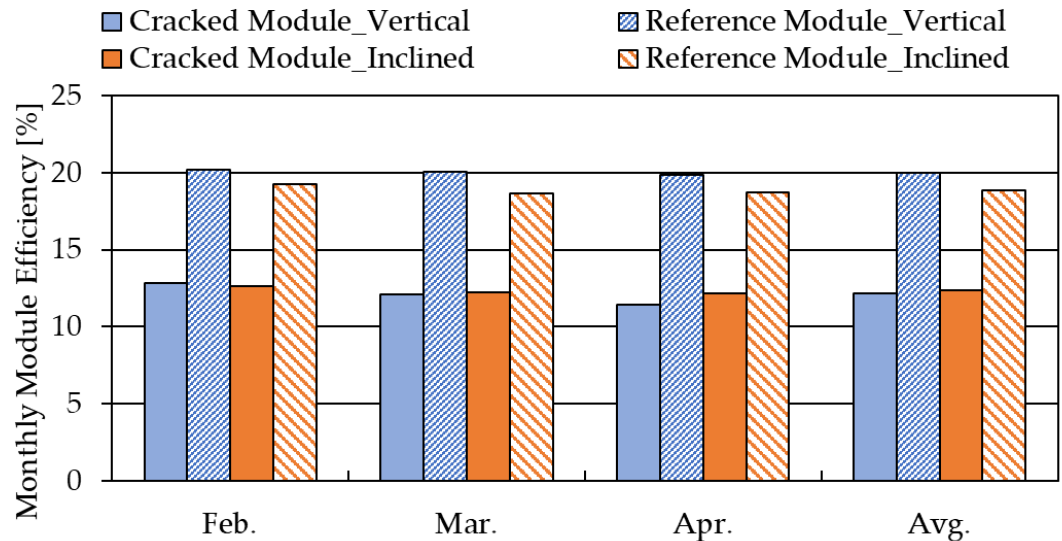
Figure 9. Comparison of monthly efficiency between reference and cracked modules.